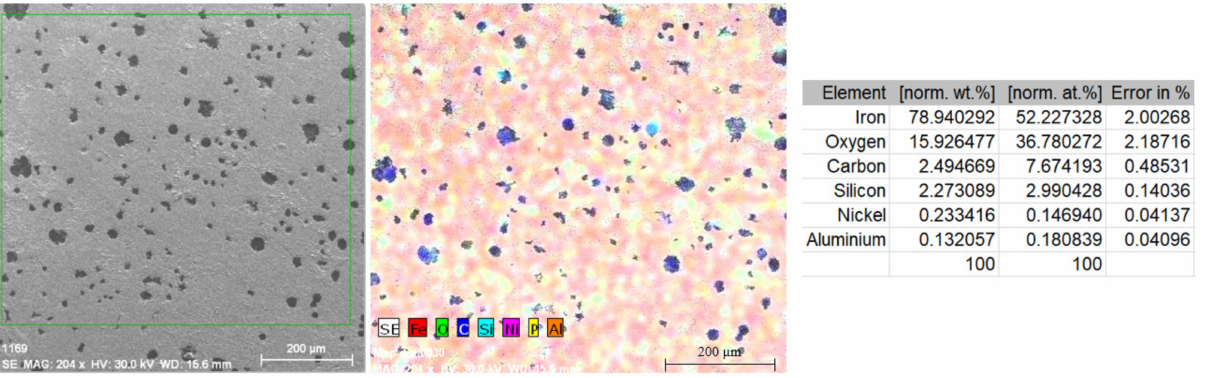
Figure 10. The surface structure of nodular cast iron after immersion for 1 h in